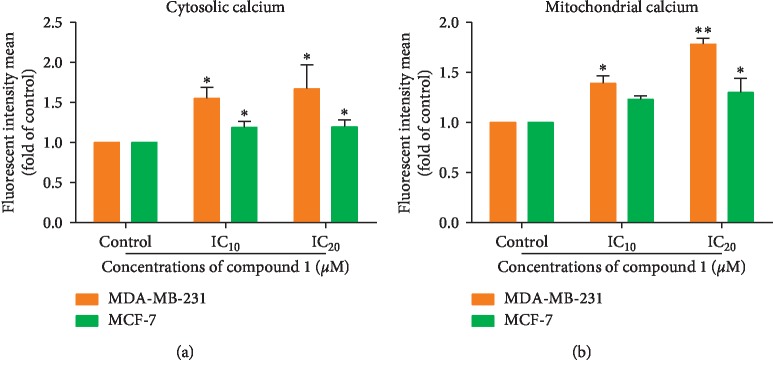
Alteration of cytosolic and mitochondrial Ca2+ levels in MDA-MB-231 and MCF-7 cells. After treatment with compound 1 for 24 hours, cancer cells were incubated with Fluo-3AM for 15 minutes to measure cytosolic Ca2+ (a). Mitochondrial Ca2+ was measured in MDA-MB-231 and MCF-7 cells after being treated cells with compound 1 for 24 hours and incubated with Rhod-2AM for 15 minutes (b). The cells were analyzed by employing flow cytometry. The data are shown as mean ± SD of fluorescence intensity as folds compared to the control (without treatment) from three independent experiments. The statistical significance value compared to the control (without treatment) is marked with asterisks, ∗p < 0.05 and ∗∗p < 0.01.